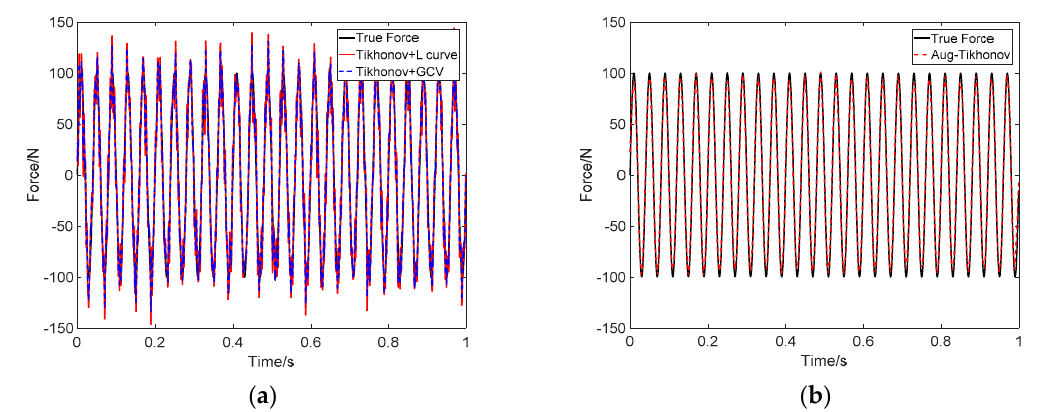
Figure 25. Identification result of sinusoidal load at SNR 30 dB on cantilever: ( a ) Tikhonov method; ( b ) the proposed method.